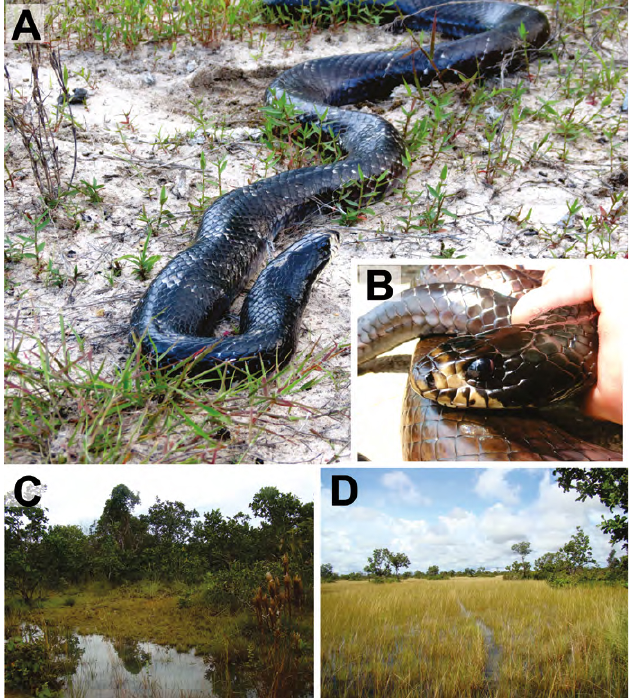
Figure 2. Hydrodynastes melanogigas and their habitats, in Mato Grosso, Brazil. A. Pattern of color of H. melanogigas according to a specimen found on 28 November 2013 in the municipality of Ribeirão Cascalheira. B. Lateral detail of the head of the specimen found on 7 March 2014 in the municipality of Ribeirão Cascalheira. C, D. View of the environments from which the specimens were recorded in the Brazilian Cerrado.